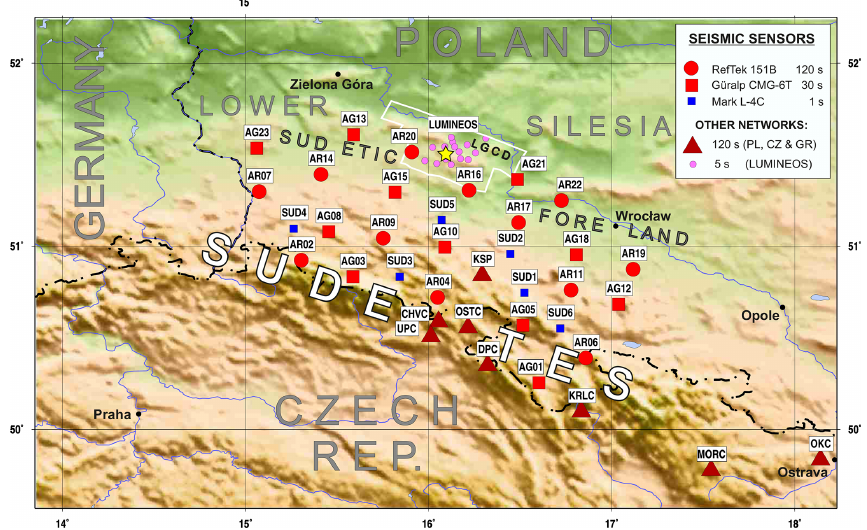
Figure 1. Location map of the AniMaLS experiment. The red circles are the temporary broadband sites with 120s sensors, the red squares are temporary sites with 30s sensors, the dark red triangles are permanent stations (120s sensors). Blue squares are short-period (1s) temporary stations. LGCD is the Legnica–Głogów Copper District. The yellow star indicates epicentre of the local event discussed in Sect. 3. Elevation map based on GTOPO30 dataset (US Geological Survey,